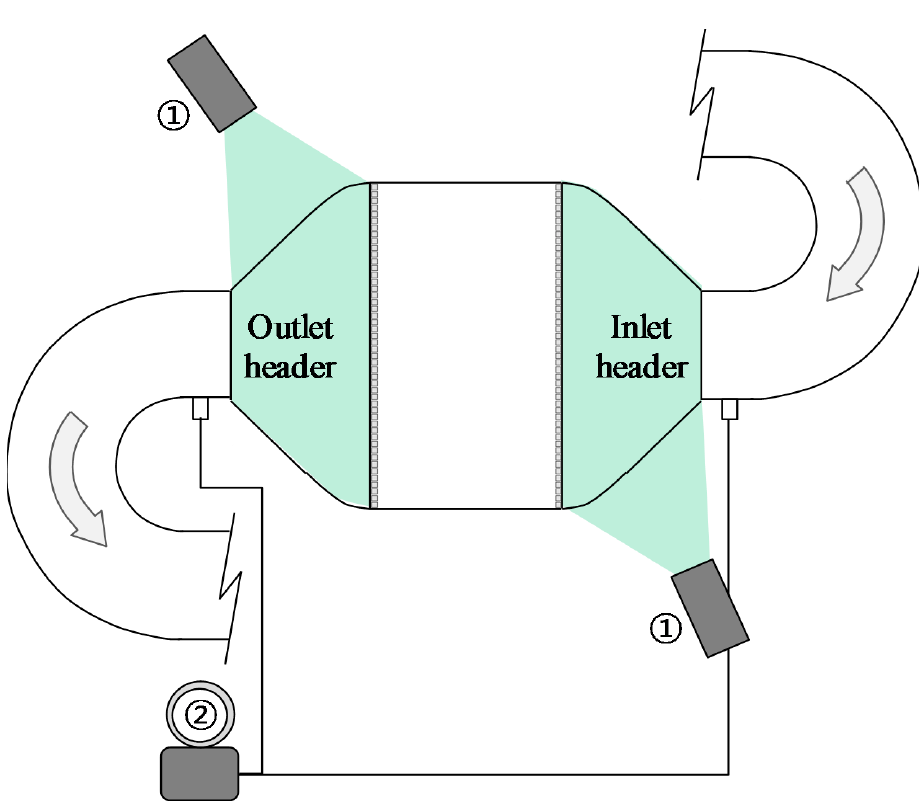
Figure 11. Schematic diagram of the test section: ① continuous laser sheet, ② differential pressure gauge.